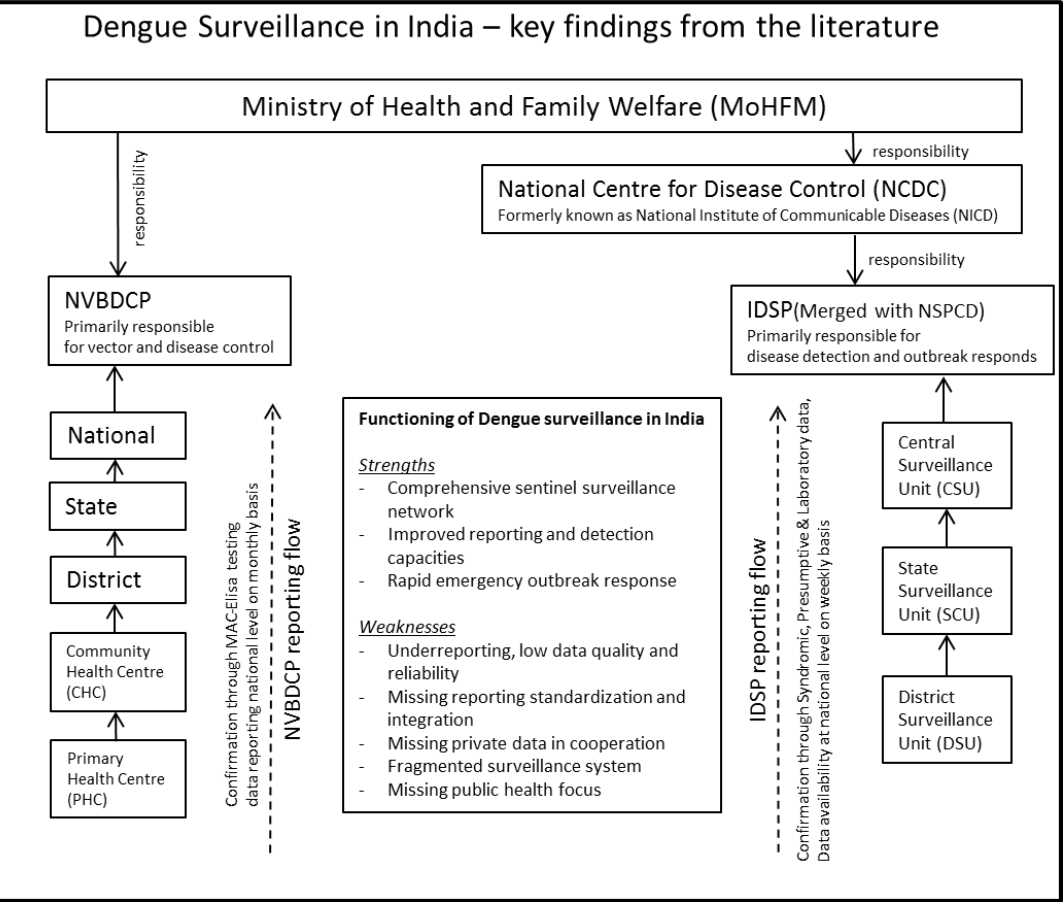
Figure 2. Key findings from the literature review. National Vector Borne Disease Control Programme (NVBDCP); Integrated Disease Surveillance Programme (IDSP); National Surveillance Programme for Communicable Diseases (NSPCD).